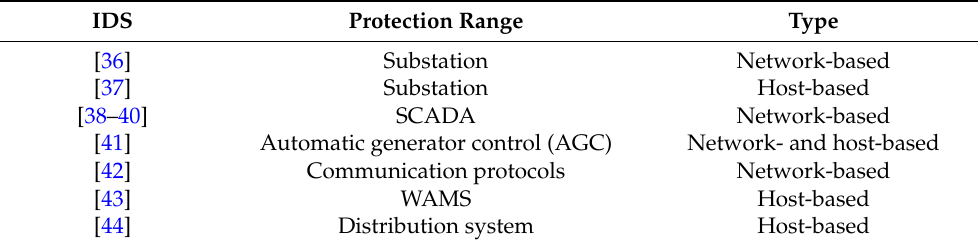
Table 4. IDSs for the smart grid.